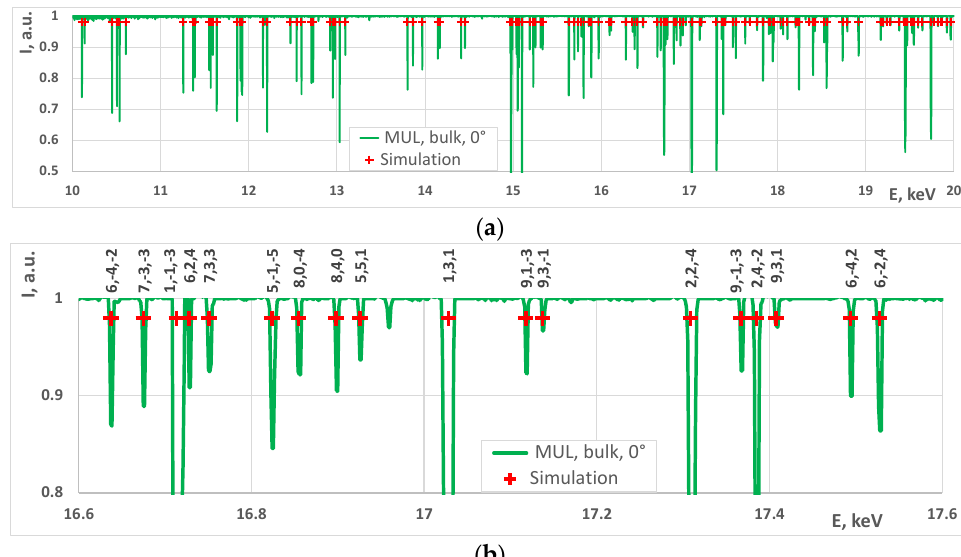
Figure 2. ( a ) Measured and simulated glitch spectrum for a diamond plate; ( b ) magnified part of the glitch spectrum for a diamond plate.